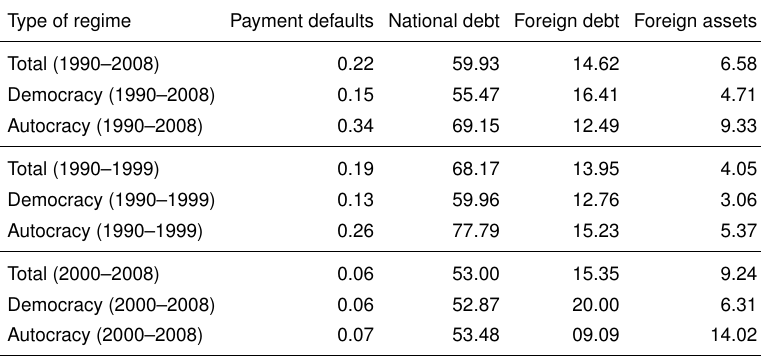
Table 4. Comparison of Means by Type of